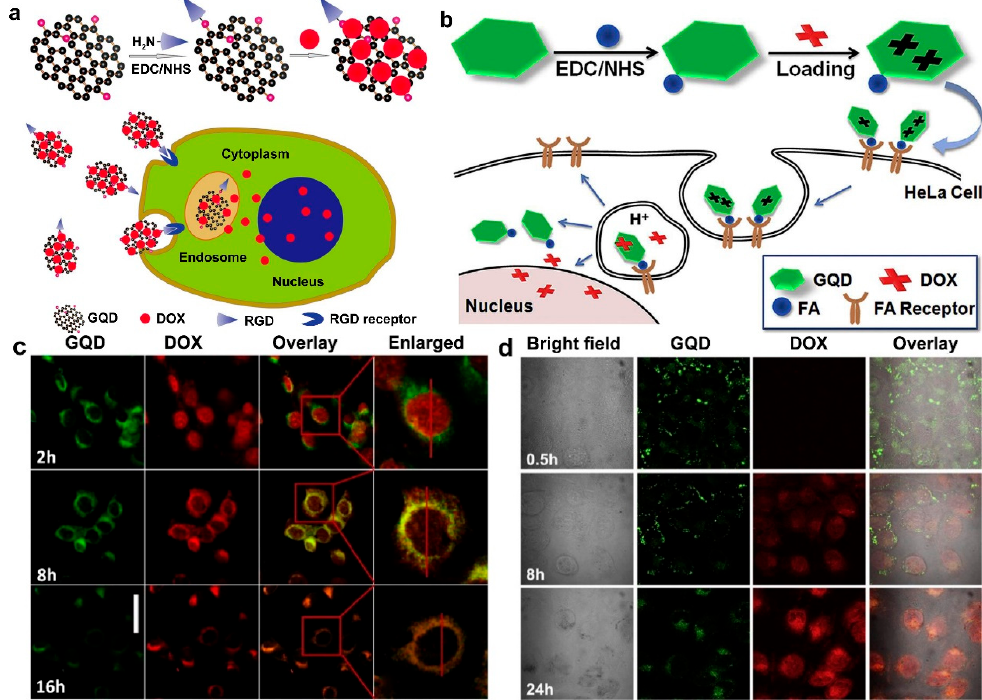
Figure 2. Small molecule-modified graphene for drug delivery. ( a ) Schematic illustration of the geometry of multifunctional graphene quantum dots (GQD) for targeted delivery of drug doxorubicin (DOX) and their interactions with cancer cells; ( b ) Schematic of the fabricated DOX- folic acid (FA)-GQD nanoassembly for DOX delivery into target cells; ( c ) DU-145 cells incubated with DOX- arginine-glycine-aspartic acid (RGD)-GQD; and, ( d ) Confocal laer scaning microscope images of HeLa cells incubated with DOX-FA-GQD. EDC: N -(3-Dimethylaminopropyl)- N ′ -ethylcarbodiimide; NHS: N -Hydroxysuccinimide. Part ( a , c ) are reproduced with permission from [45]. Copyright Dovepress, 2015. Part ( b , d ) are reproduced with permission from [78]. Copyright Elsevier, 2014.